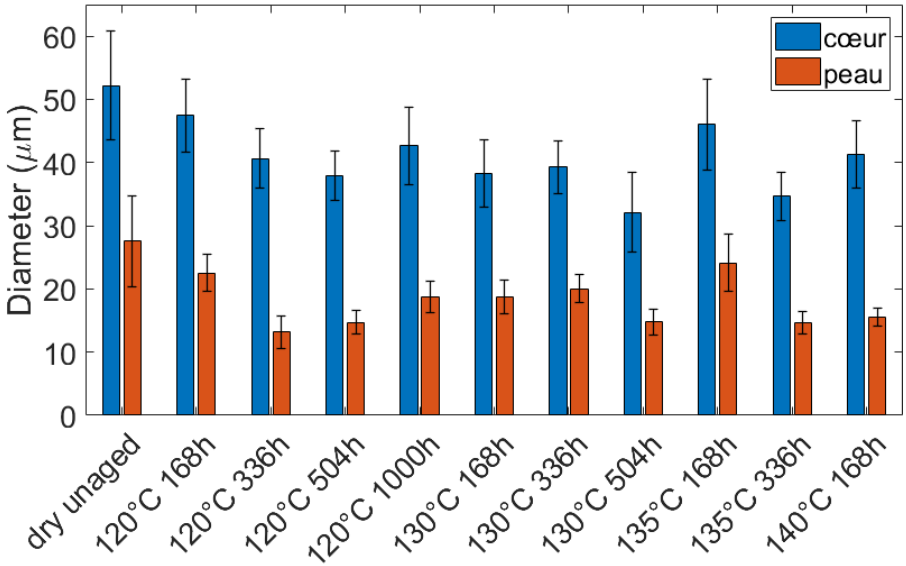
Figure 6. Spherulite diameters were measured from microscopy observations.